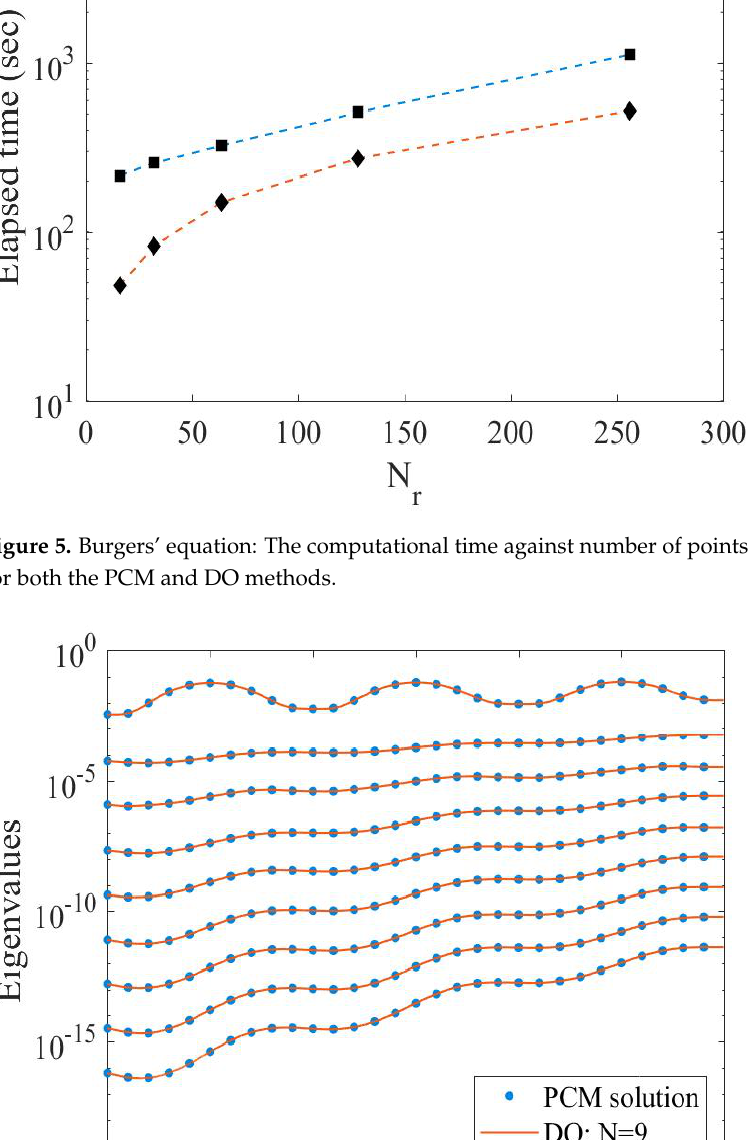
Figure 6. Burgers’ equation: The development in eigenvalues up to final time t f =5 , switching time t s =2 and the number of modes N =9